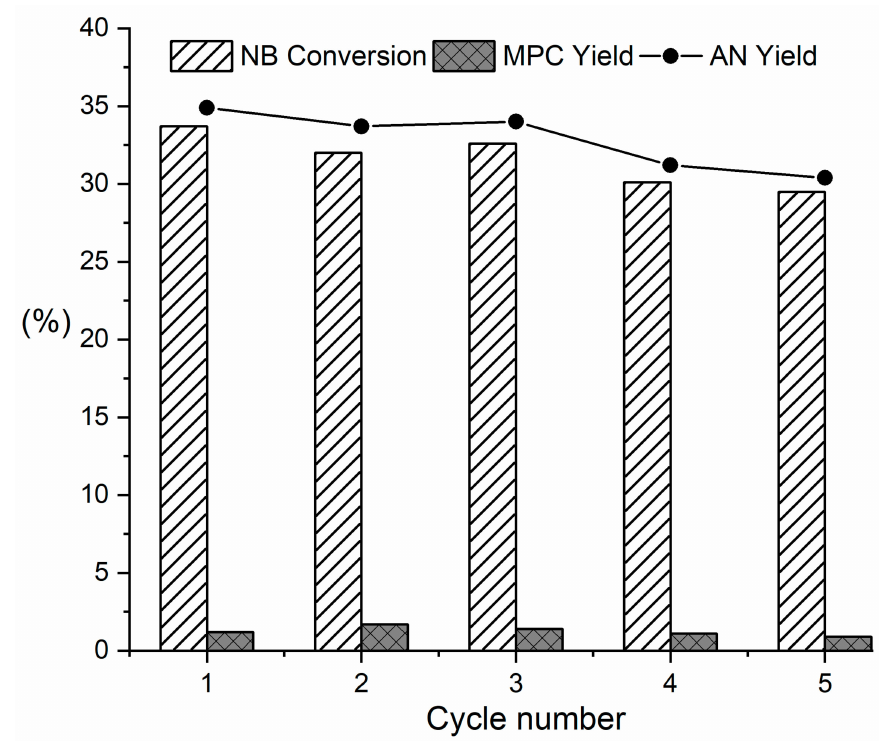
Figure 7. Catalyst recyclability in the reductive carbonylation of NB at 140 ◦ C, 6.8 MPa of CO for 2 h in the presence of 1 g of 5 wt% FeSe 2 / γ -Al 2 O 3 .